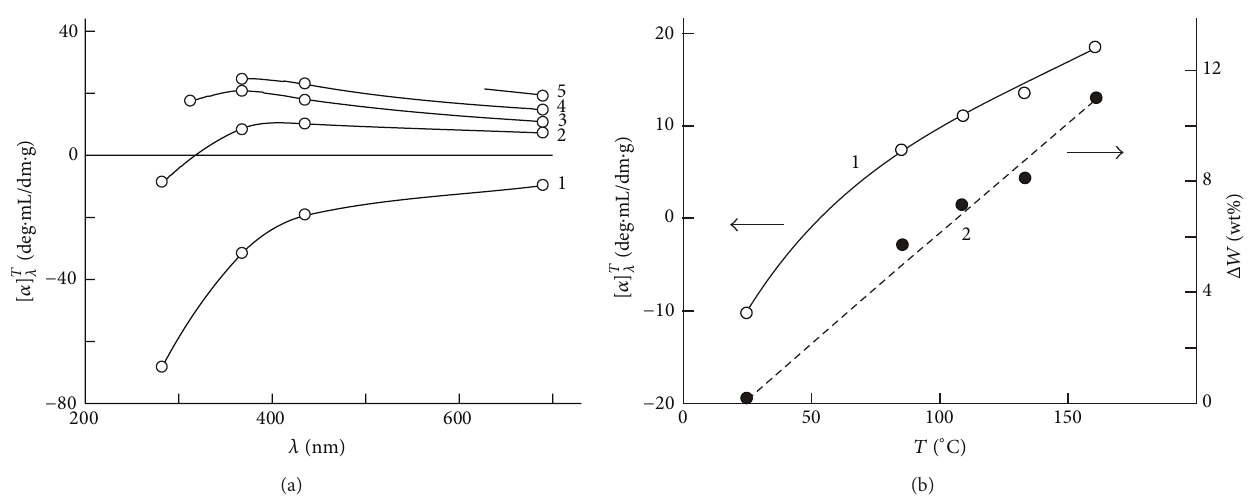
Figure 2: Change in the properties of an acetic CTS-640 film during thermal processing: (a) the ORD curves, recorded on an SPU-E, of the initial film with 𝑊 = 11.5 ± 1wt.% (1) and of the film samples thermomodified for 1.5h at 85 (2), 110 (3), 135 (4), and 160 ∘ C (5); (b) change in the specific optical rotation for 𝜆 = 691 nm (1) and the water weight loss (2) of the films as a function of the heat treatment temperature.